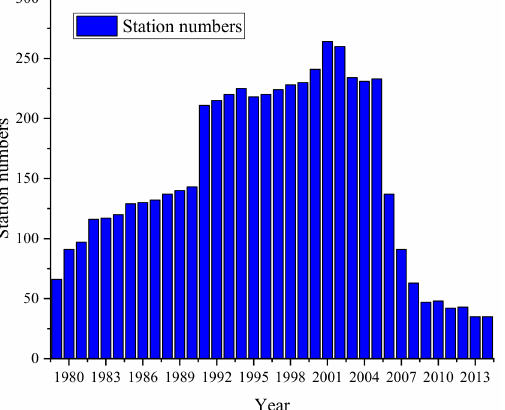
Figure 2. Station numbers of available data from 1979 to 2014.